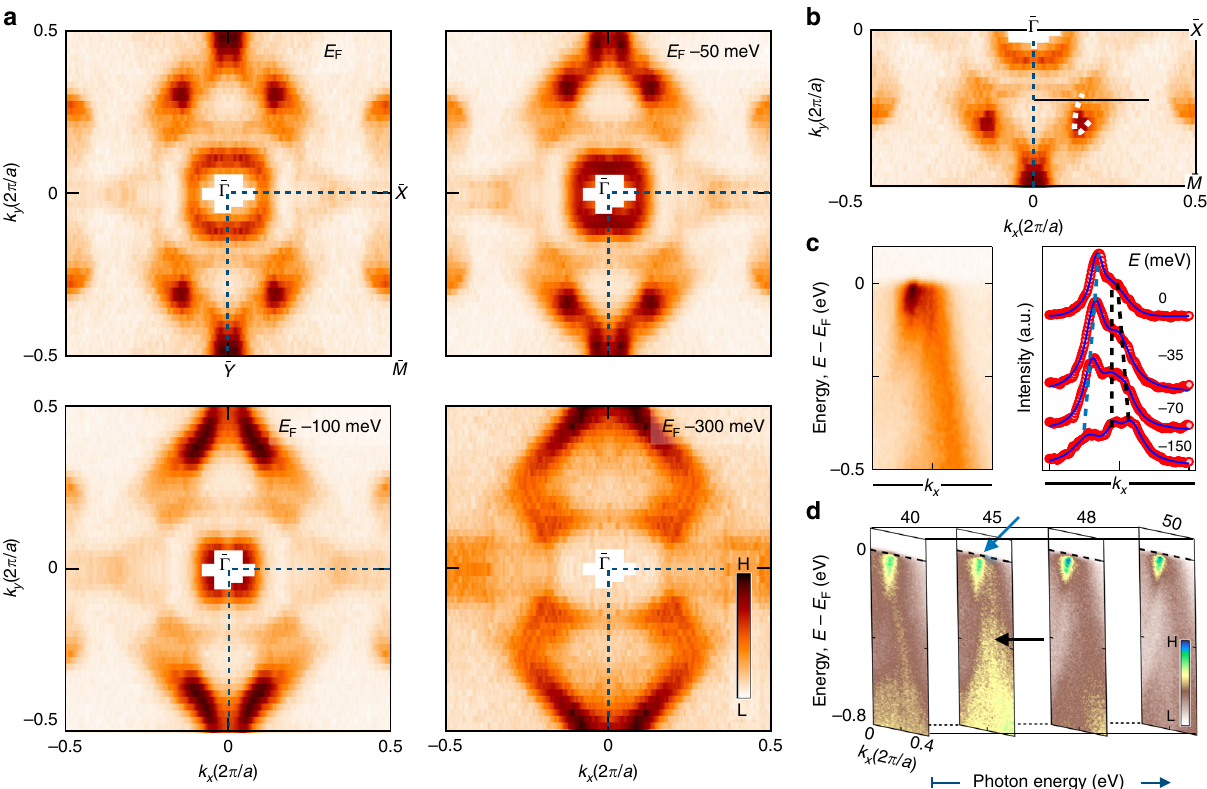
Fig. 2 Fermiology and topology of the (001) surface electronic structure in PrAlGe. a Low-energy ARPES-measured Fermi surface and constant binding energy contours obtained with incident photon energies of 50 eV at T ≈ 11K. Blue dashed line: one quadrant of the surface Brillouin zone. b ARPES- measured Fermi surface with guides to the eye (white dashed line) tracking the “ U ” shaped candidate topological Fermi arc state. c Left: energy- momentum cut and, right: MDCs fi tted at different binding energies with Lorentzian functions to track the candidate arc (blue dashed line) and bulk states (black dashed lines). The corresponding path is shown in b . d Photon-energy dependent ARPES along the horizontal line in b . Negligible k z dispersion is observed for the candidate “ U ” shaped topological Fermi arc (blue arrow). Strong photon-energy dependence is observed for other states nearby (black arrow), suggesting that they are bulk